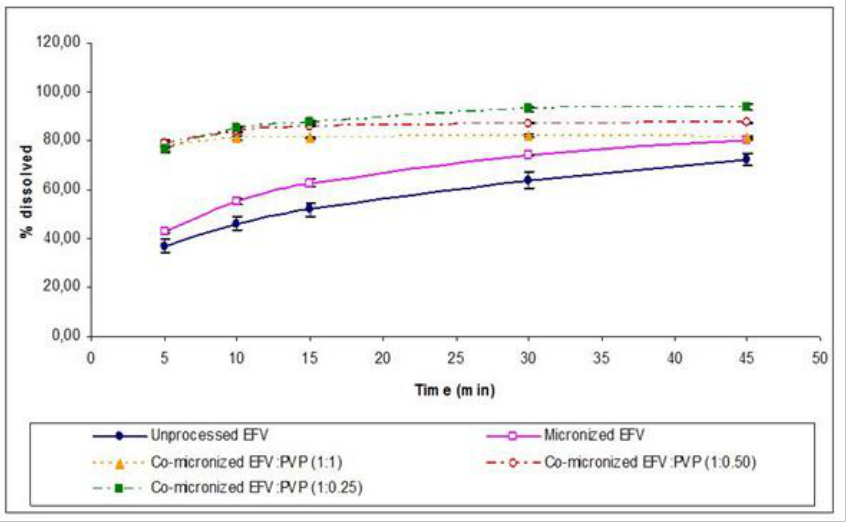
Figure 15. Powder dissolution profile of EFV in SLS 0.5% ( n = 3) compared to micronized and unprocessed EFV and co-micronized EFV:PVP mixtures at the proportions (1:0.25), (1:0.50) and (1:1).